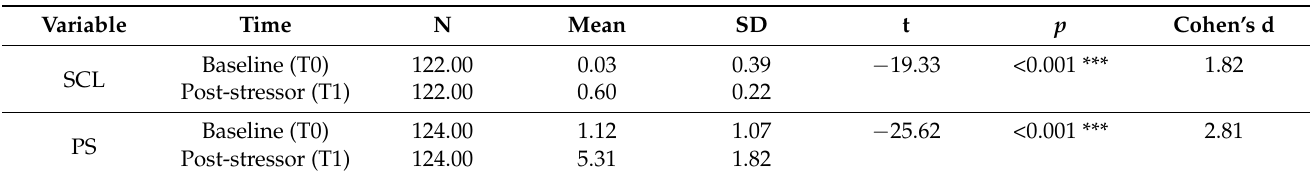
Table 1. Paired t test results and mean values in skin conductance level (SCL) and perceived stress (PS) before and immediately after exposure to the